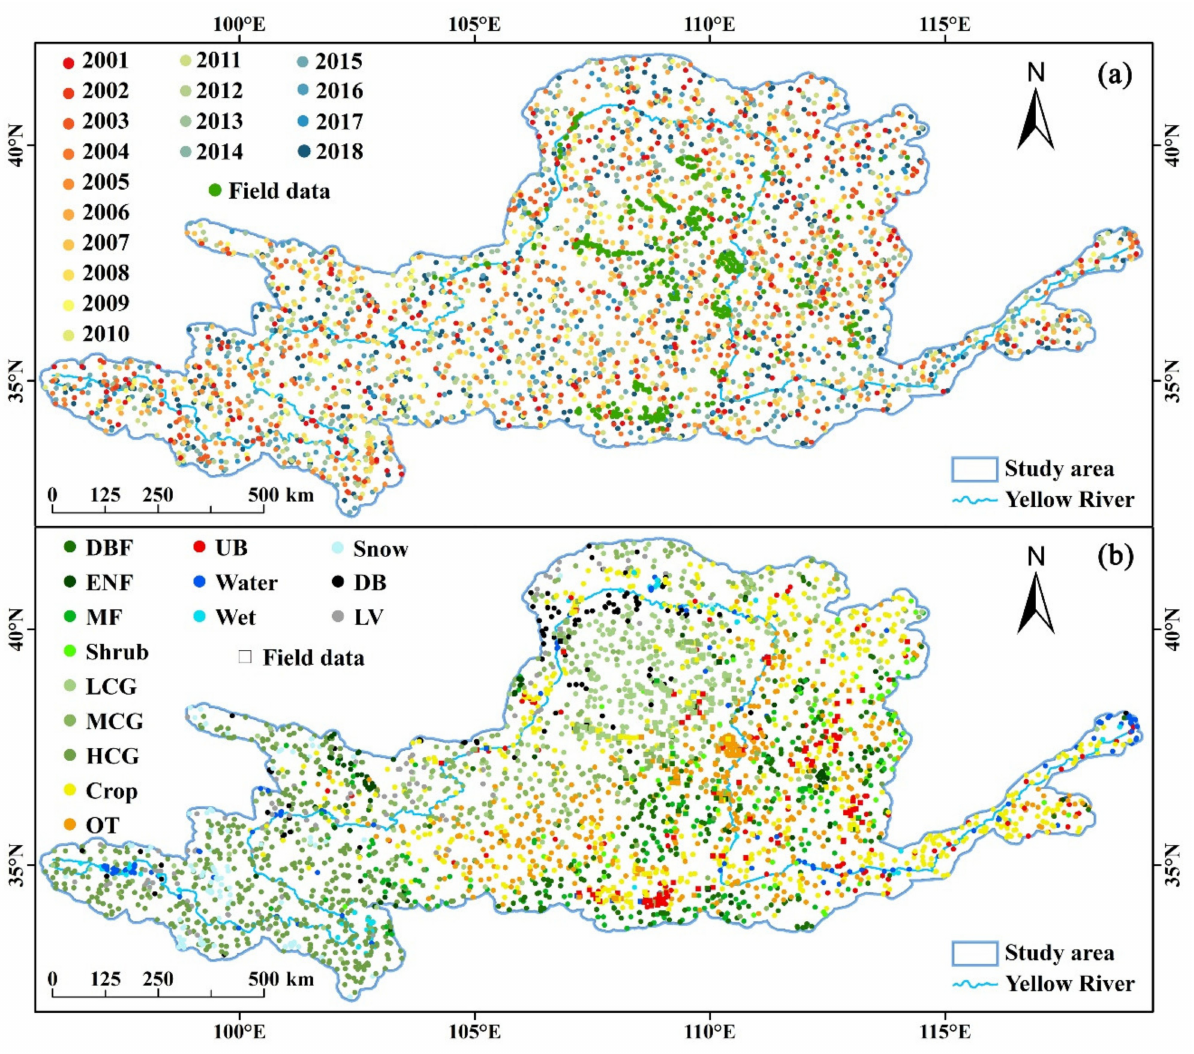
Figure 4. ( a ) The year and geographical distribution of validation points sets. ( b ) The class and geographical distribution of validation points sets. Including 3456 random validation points on Google Earth and 640 ground points from the field